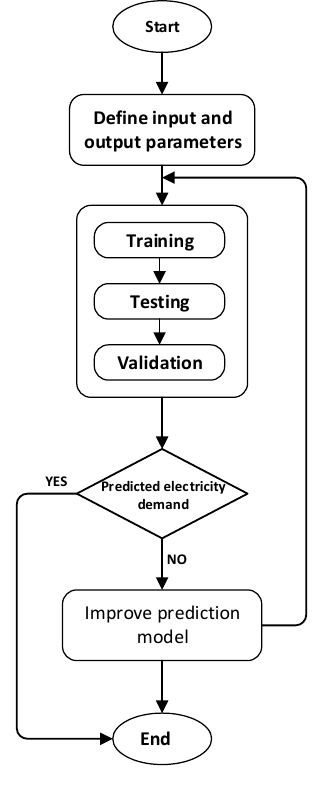
Figure 6. ANN Flowchart.